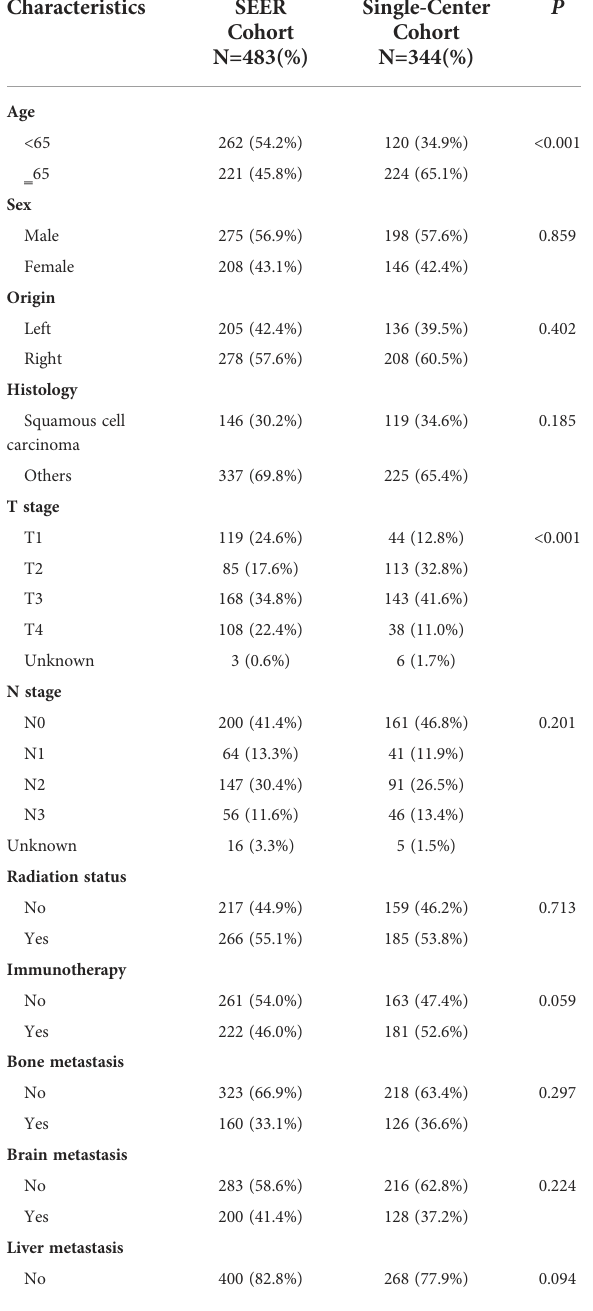
TABLE 1 Baseline characteristics of all patients in the SEER and the single-center